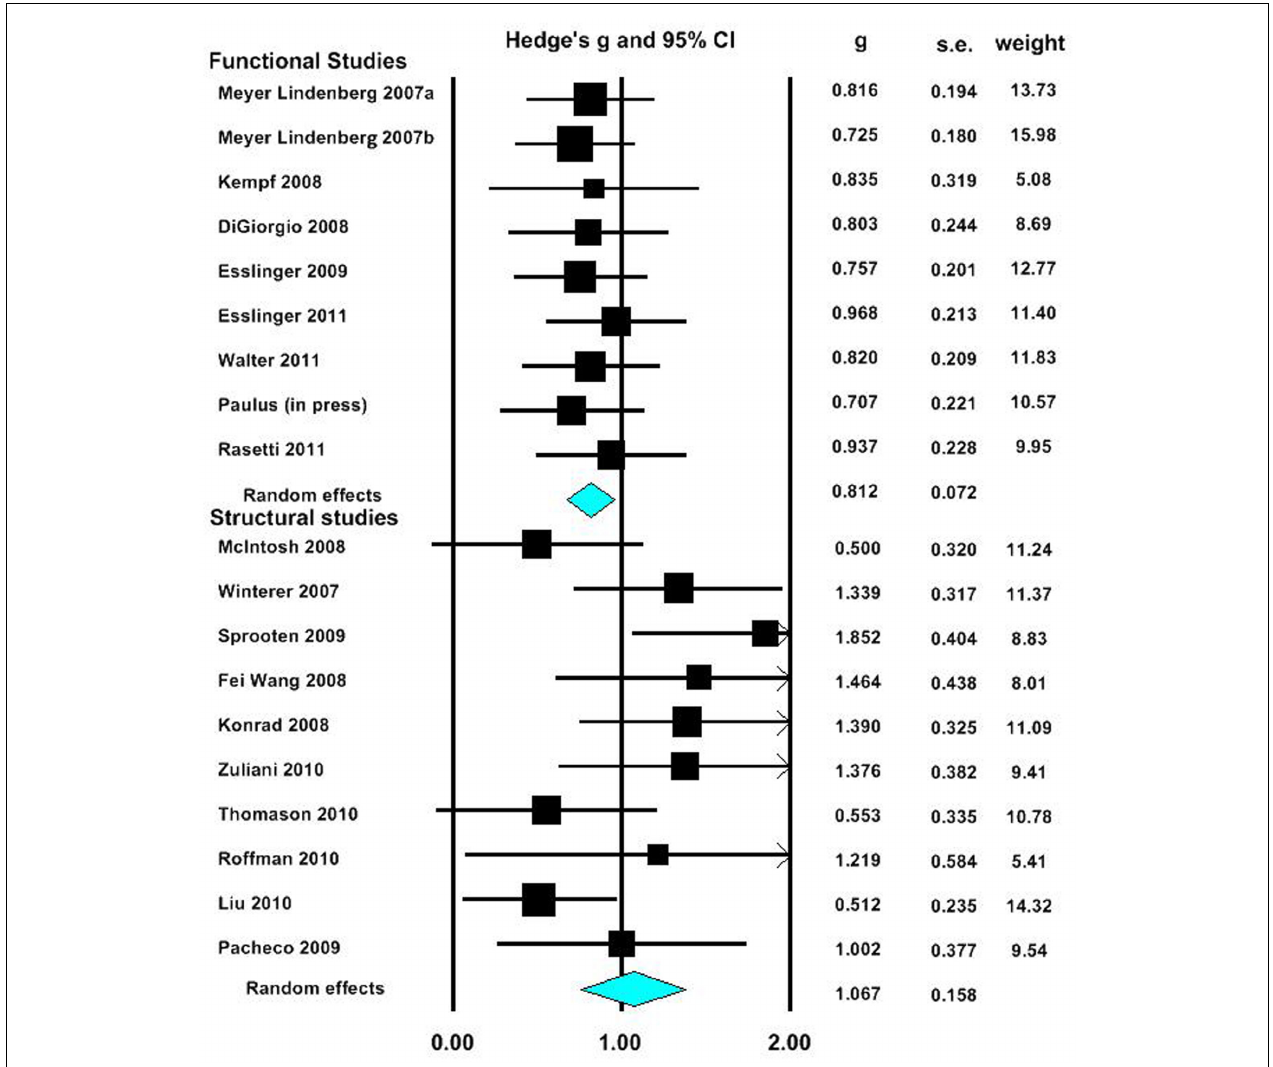
FIGURE 1 | Forest plot reporting Hedges’ g and 95% CI for the analysis showing the largest effect size in each paper. CI, confidence interval; g, Hedges’ g ; SE, standard error.